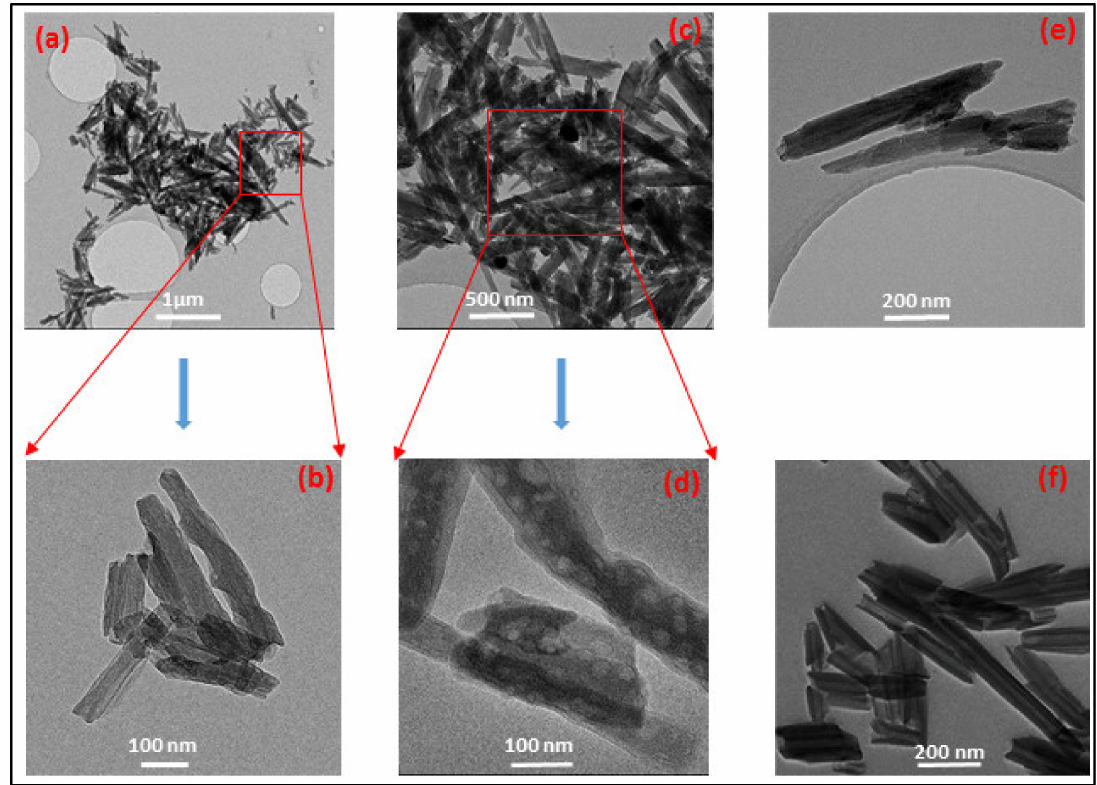
Figure 4. TEM images of HNT-DMA-PPy@Ag nanocomposites ( a–e ) and unmodified HNT ( f ).